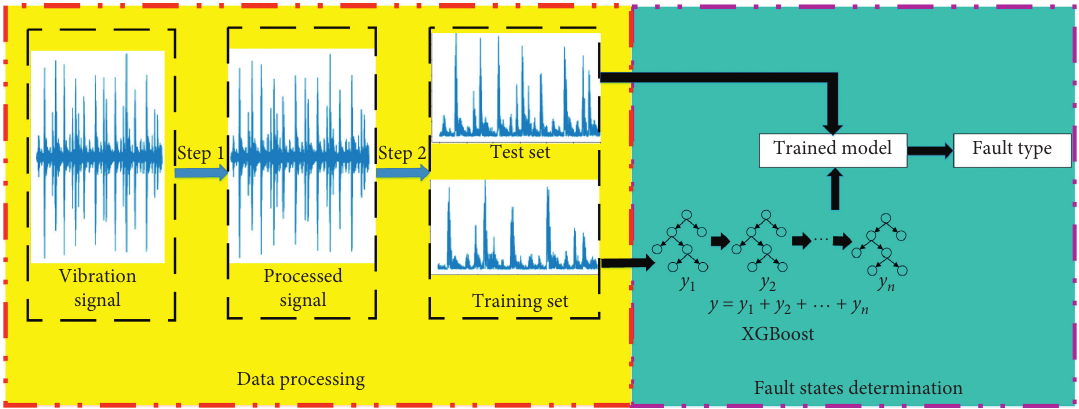
Figure 4: Diagnosis procedure of DIT-FFT-XGBoost.